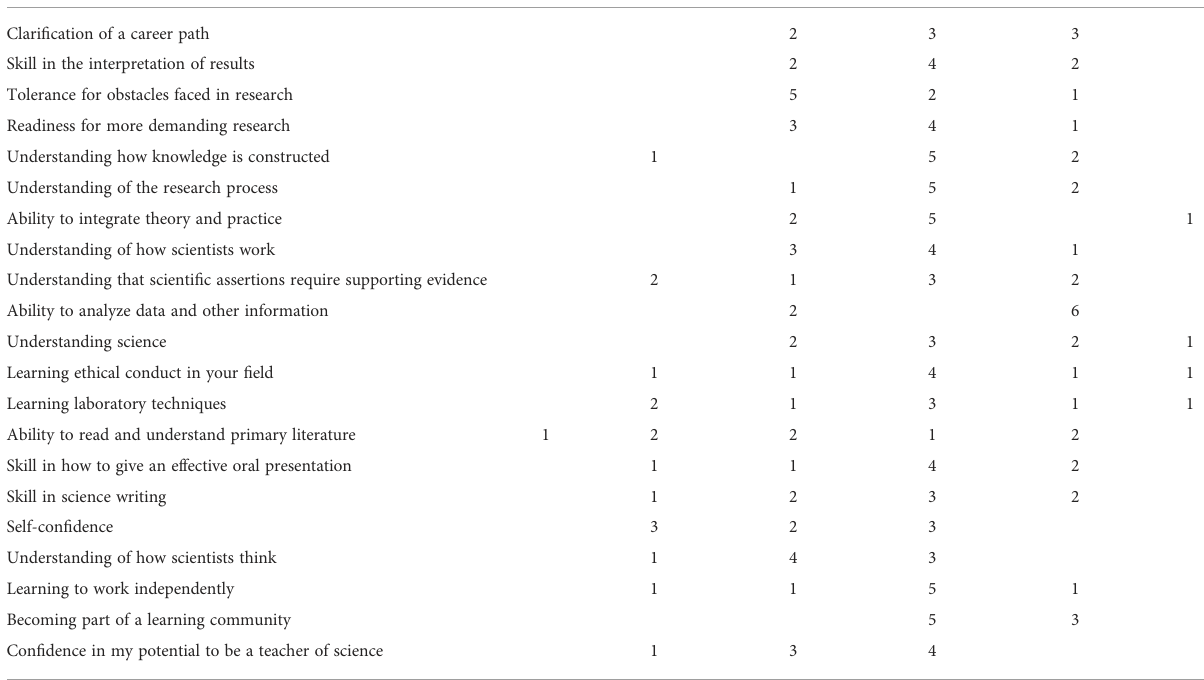
TABLE 2 Self-reported student gains from directed study research experiences. Possible bene fi ts of research experience No gain Small gain Moderate gain Large gain Very large gain